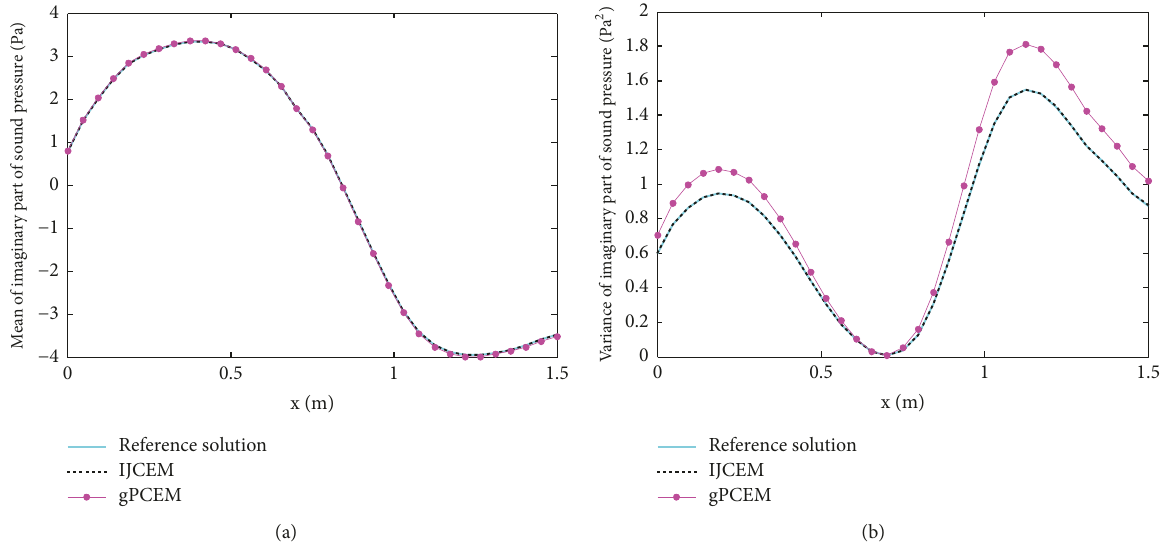
Figure 9: Mean and variance of sound pressure of car along the bottom boundary at f=200Hz: (a) mean and (b)